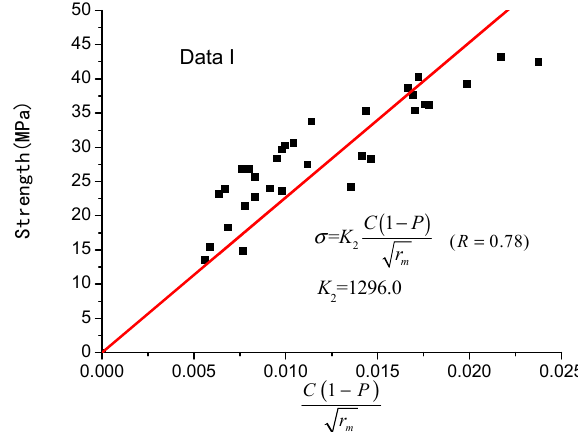
Figure 1. Equation (6) strength model (data I).